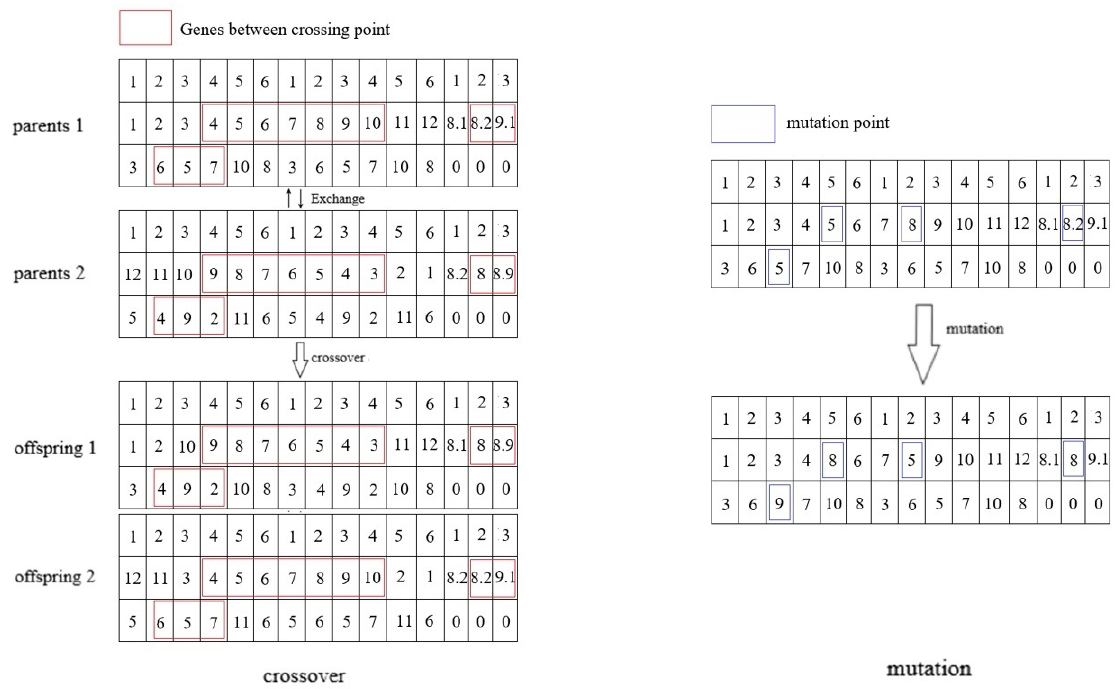
Figure 5. Illustration of the crossover and mutation operations. After determining the mutation operation to be performed based on the mutation probability, for the service sequence encoding, two numbers between 0 and 2I are randomly generated as the mutation points, and the genes of the two mutation points are exchanged in the chromosome. For the berth encoding, a number between 0 and I is randomly generated as the mutation point, and a berth is randomly selected from the assignable berths based on the vessel’s position; the number of this berth is then used to replace the mutation point gene. For the speed encoding, a number between 0 and K is randomly generated as the mutation point; the speed is then randomly generated within the specified speed range and used to replace the mutation point gene. After the mutation operation has been performed on all of the chromosomes (line 16 in the algorithm), the correction operation (line 17) is carried out to generate the offspring